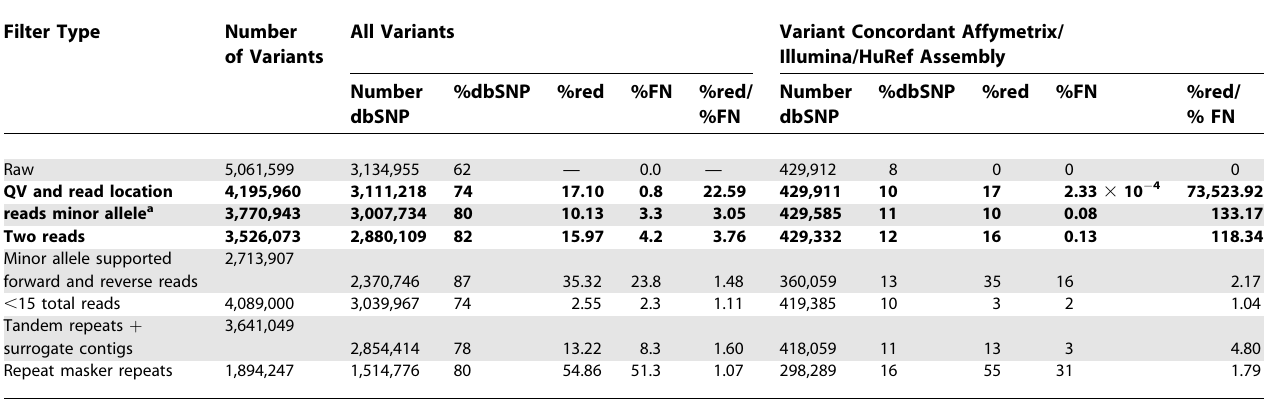
Table 3. The Application of Distinct, Independent, Filtering Methods on the Detection Rate of SNPs, Heterozygous Indels, and Complex Variants Identified from the HuRef Assembly Filter